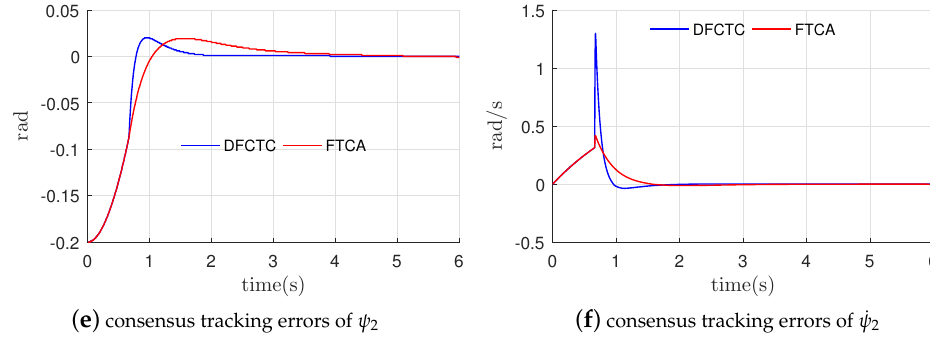
Figure 6. Consensus tracking errors for agent i = 2.